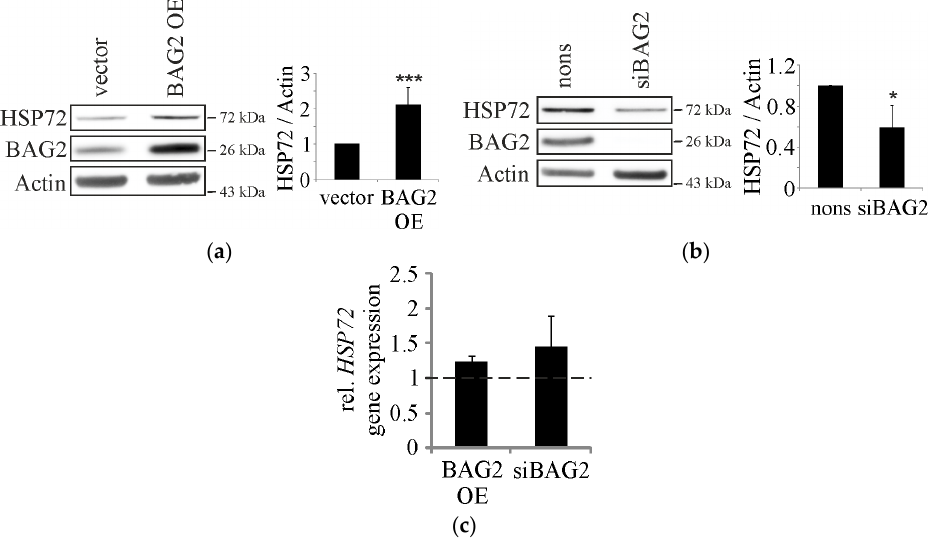
Figure 1. BAG2 modulates HSP72 protein levels. ( a ) Immunoblot analysis of cells that were transfected with the indicated plasmids. Actin served as control for equal loading. Statistics are depicted as mean ± SD. *** p < 0.001, n = 6; ( b ) Immunoblot analysis of cells that were manipulated with nonsense or BAG2 siRNA. Actin served as loading control. Statistics are depicted as mean ± SD. * p < 0.05, n = 4; ( c ) Real-time PCR analyses of HSP72 mRNA levels in cells that were manipulated as indicated. Statistics are depicted as mean values ( ± SD) relative to HSP72 mRNA levels in cells that are treated with empty vector or nonsense siRNA, respectively. n =